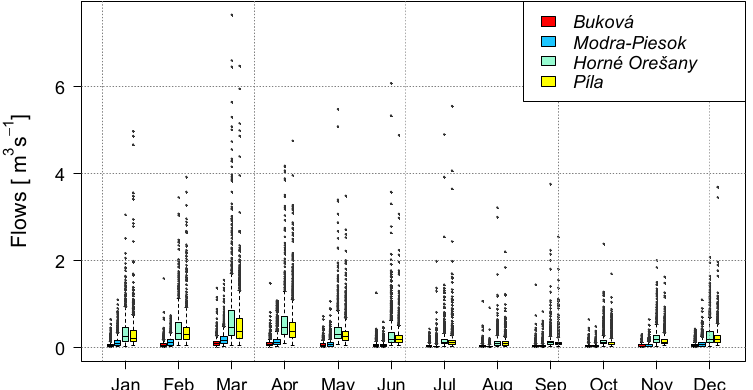
Figure 1. Location of selected catchments.